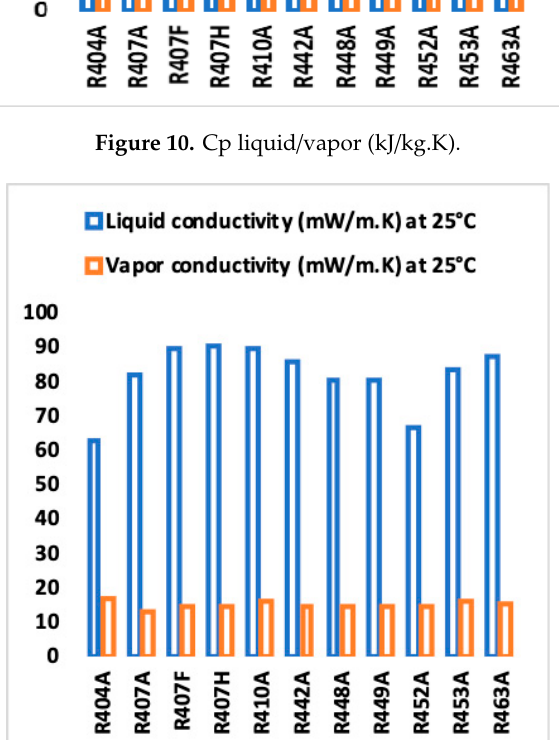
Figure 11. Liquid / vapor conductivity (mW / Figure 11. Liquid/vapor conductivity (mW/m.K). Figure 11. Liquid/vapor conductivity (mW/m.K).